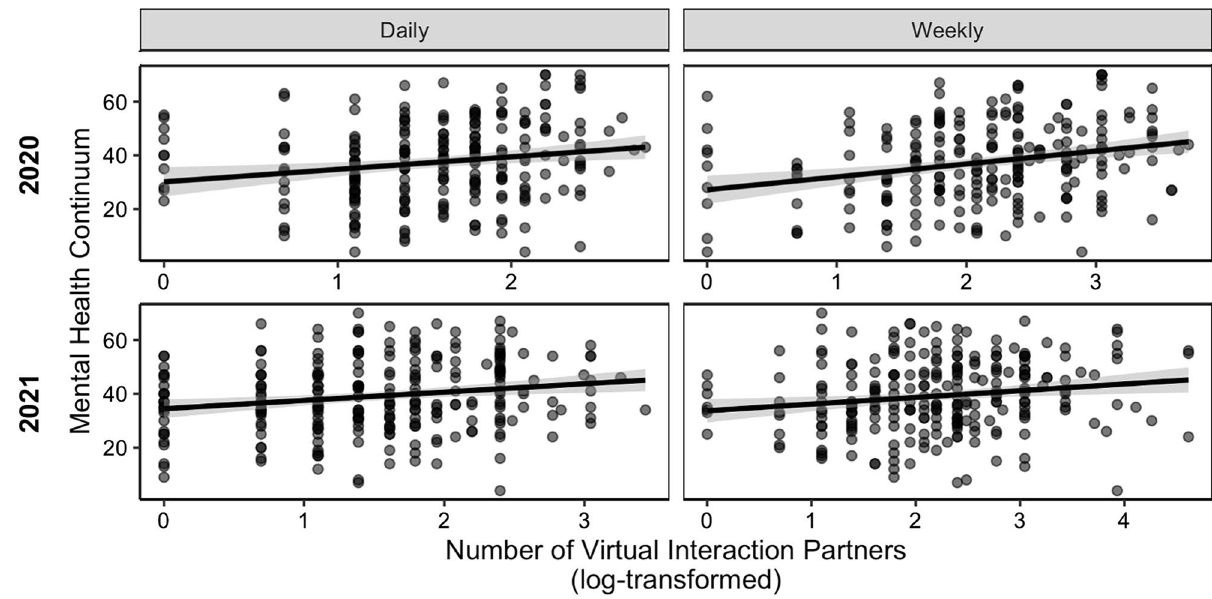
Figure 1. Association between number of virtual interaction partners and mental health. Mental health, as measured by the Mental Health Continuum, was positively associated with the number of people participants virtually interacted with on a daily and weekly basis in both 2020 and 2021. 95% confidence intervals around the linear regression line are shown 29